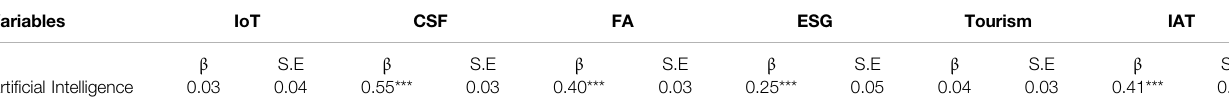
TABLE 2 | Standardized estimates of direct effects for the paths of intelligent automation in tourism ( N = 402). Variables